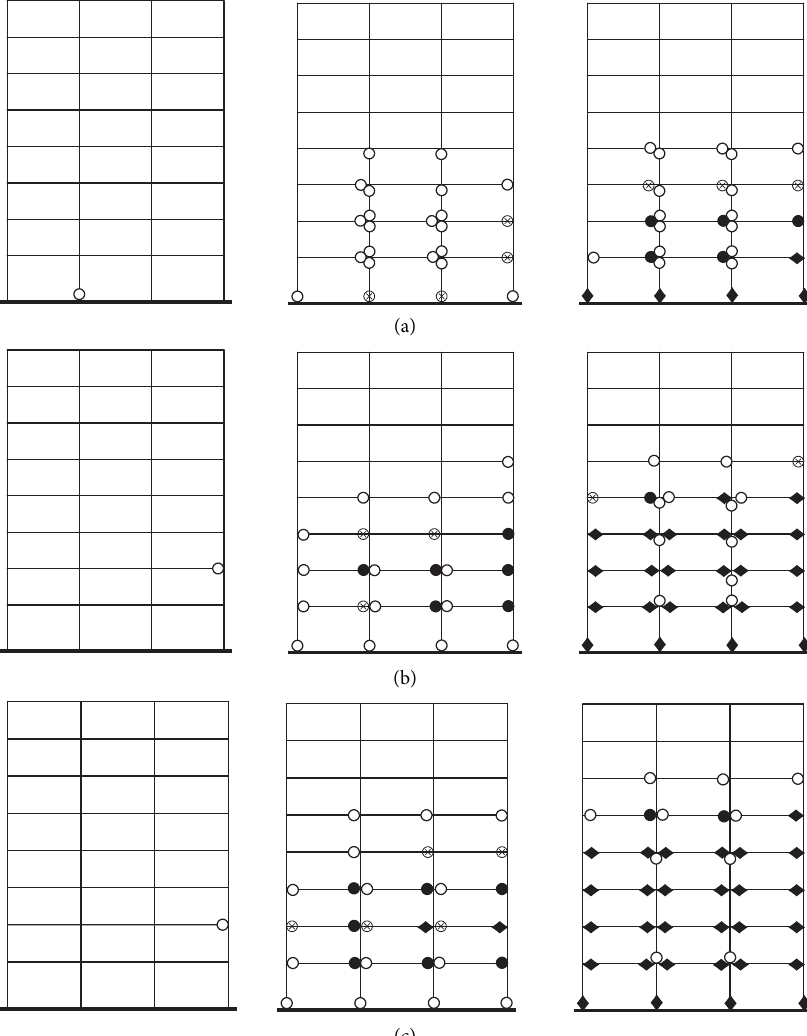
Figure 7: Plastic hinge development process for different failure mode. (a) Column hinge failure mode ( η ( η c � 1.6). (c) Beam hinge failure mode ( η c �